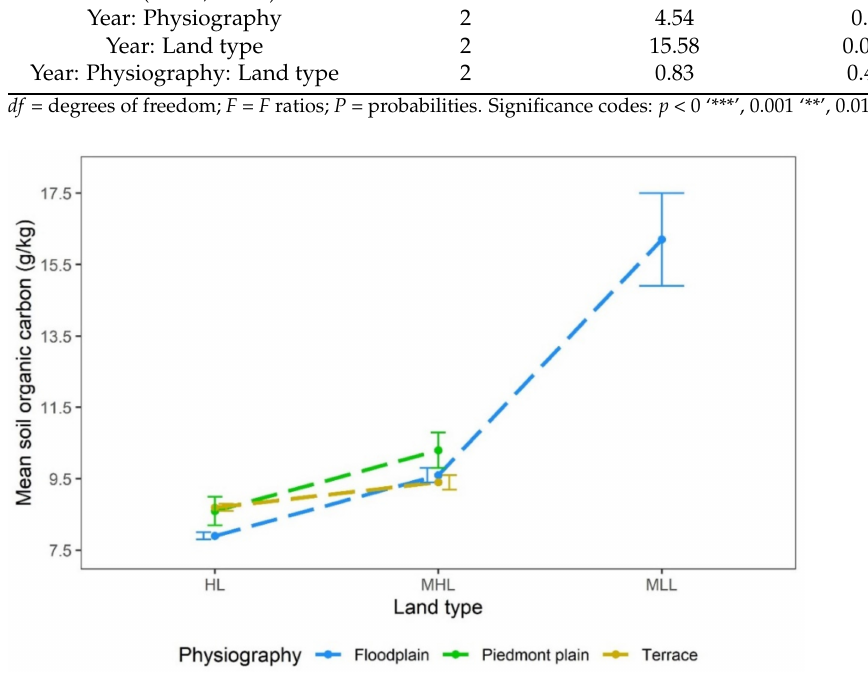
Figure 2. The main effect of land type (highland = HL, medium highland = MHL, medium lowland = MLL) on SOC contents (0–15 cm) in the Floodplain, Piedmont plain and Terrace